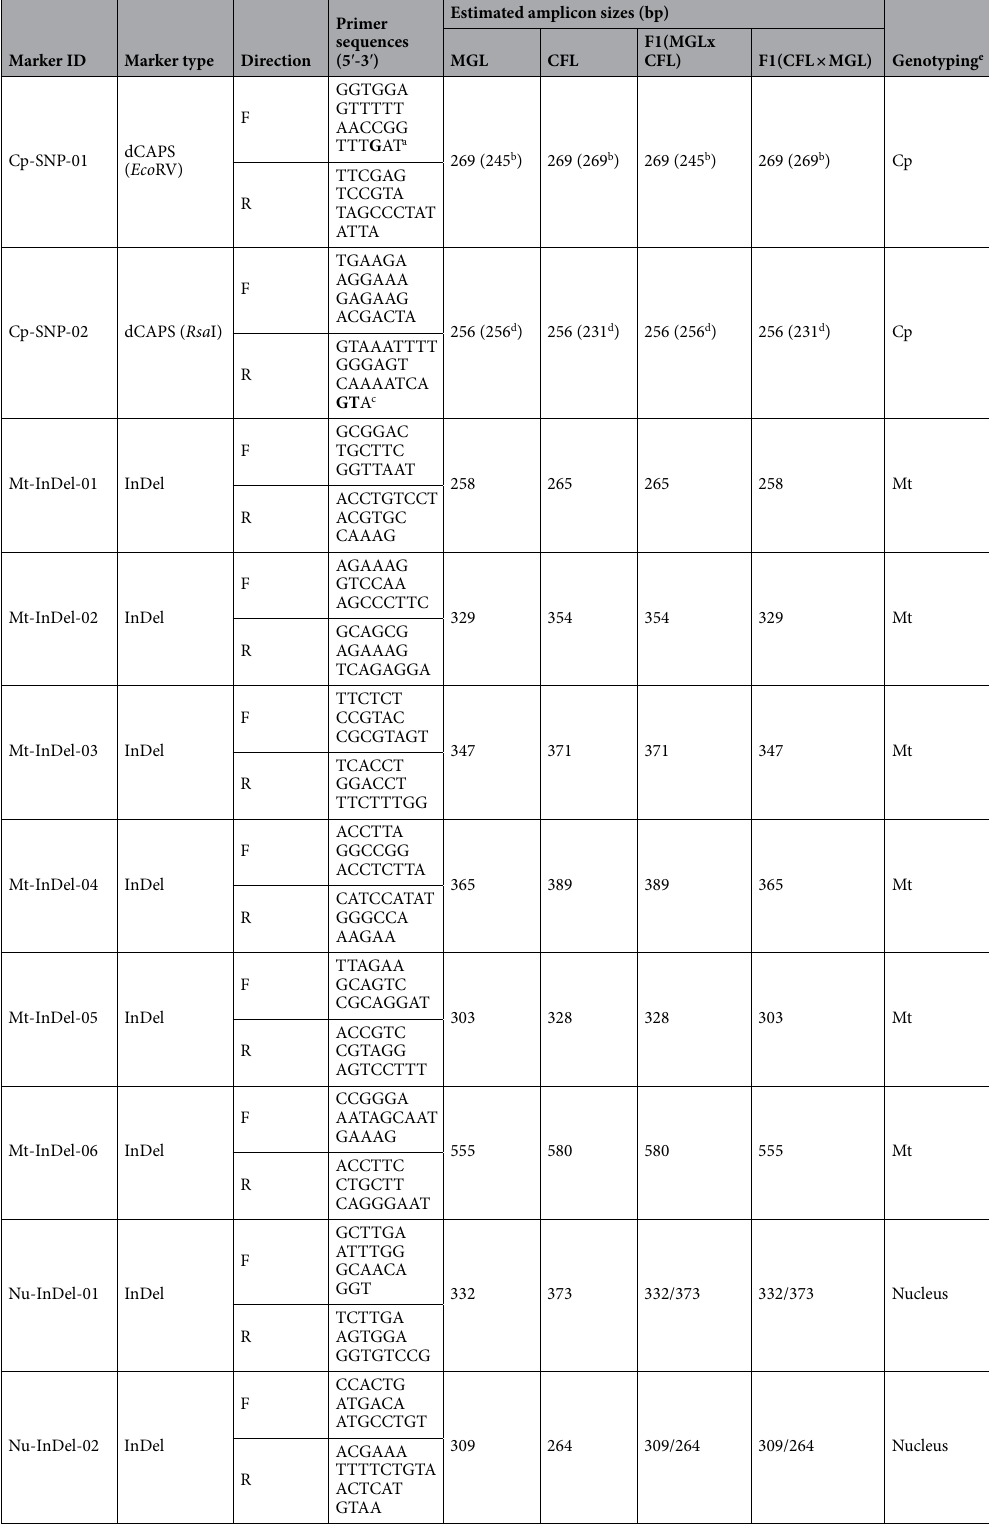
Table 3. Molecular markers designed in this study. a,c Bold letters indicate modified bases for cleavage of PCR amplicon by restriction enzymes ( Eco RV and Rsa I). b,d Fragment size after cleavage of PCR amplicon by restriction enzymes for each dCAPS marker. e Cp indicating chloroplast and Mt indicating